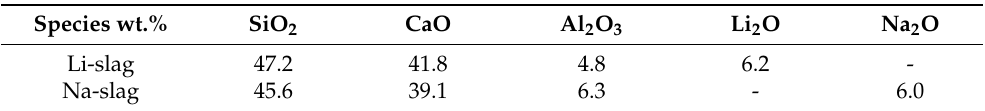
Table 1. Chemical analysis of investigated slags by XRF (for CaO, Al 2 O 3 and SiO 2 ) and ICP-OES (for Li 2 O and Na 2